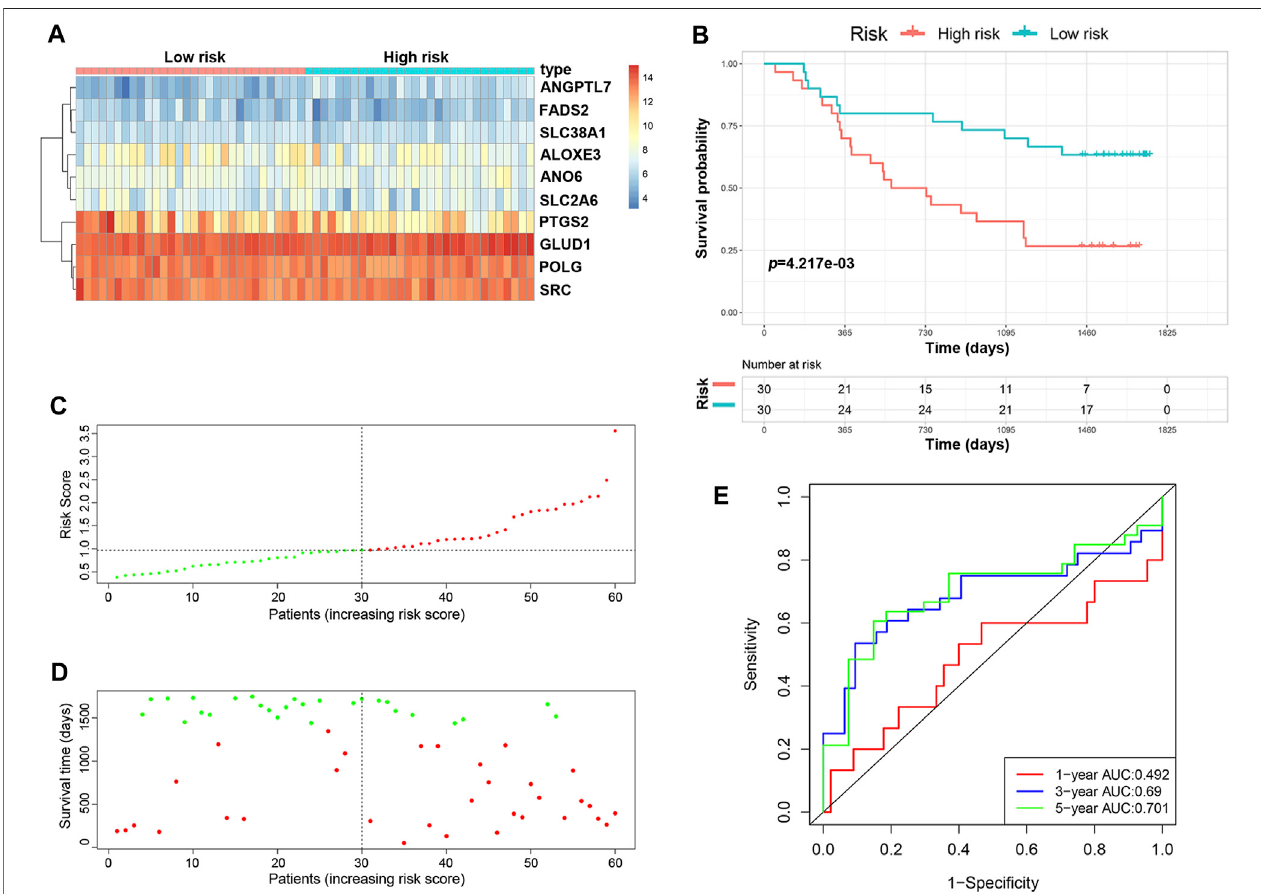
FIGURE 3 | Validation of the predictive risk model in an independent cohort. (A) The heatmap displays the expression pro fi le of the ten FRGs in the GSE53622 dataset. (B) Kaplan-Meier survival curves showed the OS of patients in the GSE53622 dataset. (C) The distribution and median value of the risk score in the GSE53622 dataset (red: high-risk; green: low-risk). (D) Survival status plots of patients in the GSE53622 dataset (red: death; green: survival). (E) ROC curves of the risk model for predicting the 1-, 3- and 5-years OS of patients in the GSE53622 dataset.